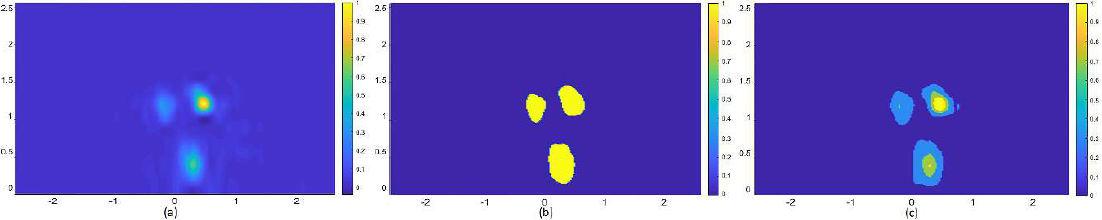
Figure 16. Segmented images of interference sources with same frequency. ( a ) original image; ( b ) two thresholds segmentation; ( c ) three thresholds segmentation.